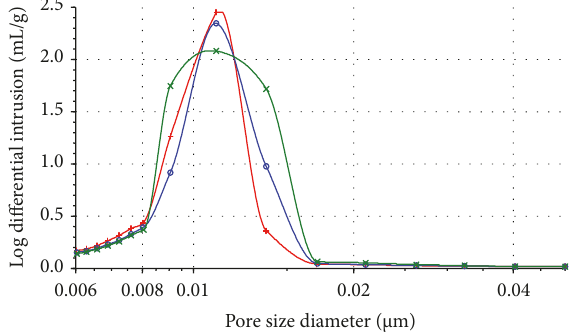
Figure 3: Intrusion of mercury as a function of pore diameter for samples 1 (+), 4 ( × ), and 5 ( ∘